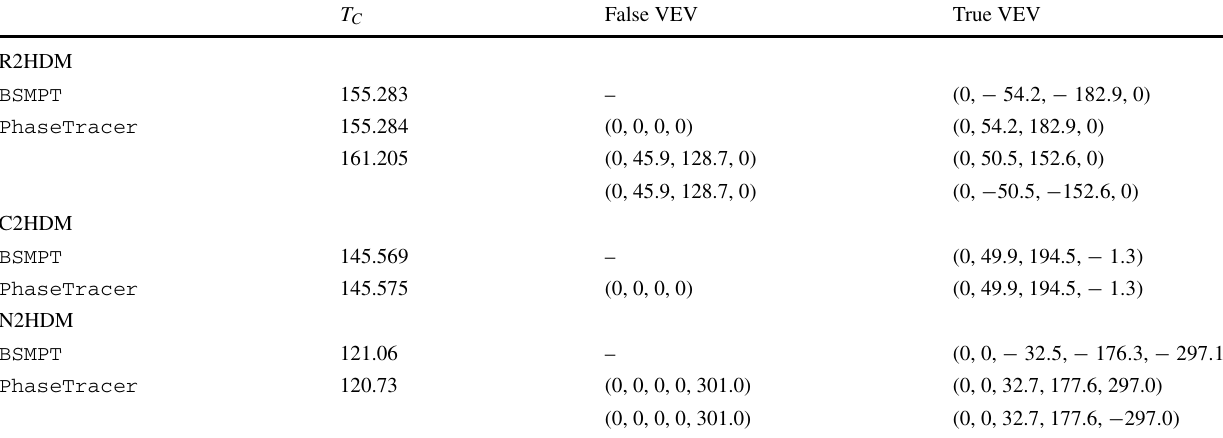
Table 4 Results of PhaseTracer and BSMPT-1.1.2 for the R2HDM, C2HDM and N2HDM benchmark points